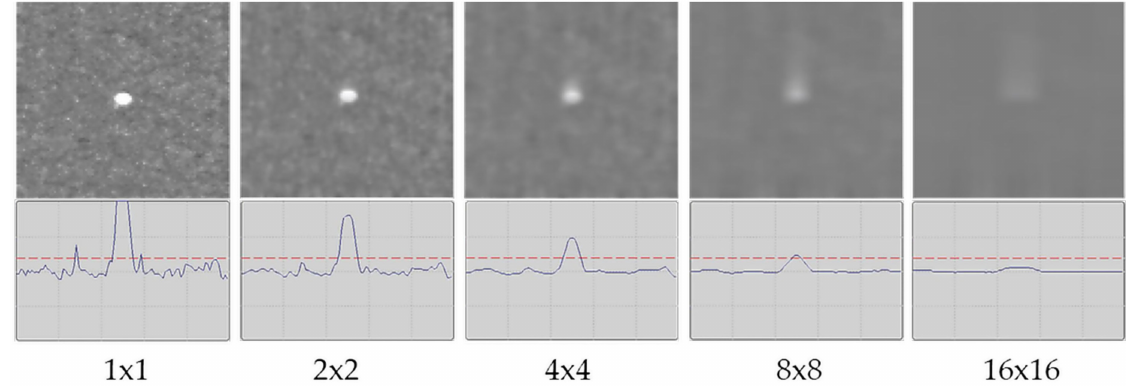
Figure 2. Detection filters and their effect on noise (phantom defects) and real defects.